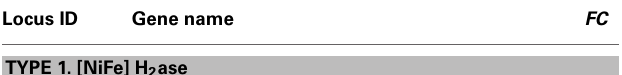
Table 4 | C. thermocellum genes encoding putative hydrogenases, sensory hydrogenases, and NADH:Fd oxidoreductases using ferredoxin and NAD(P)H as electron